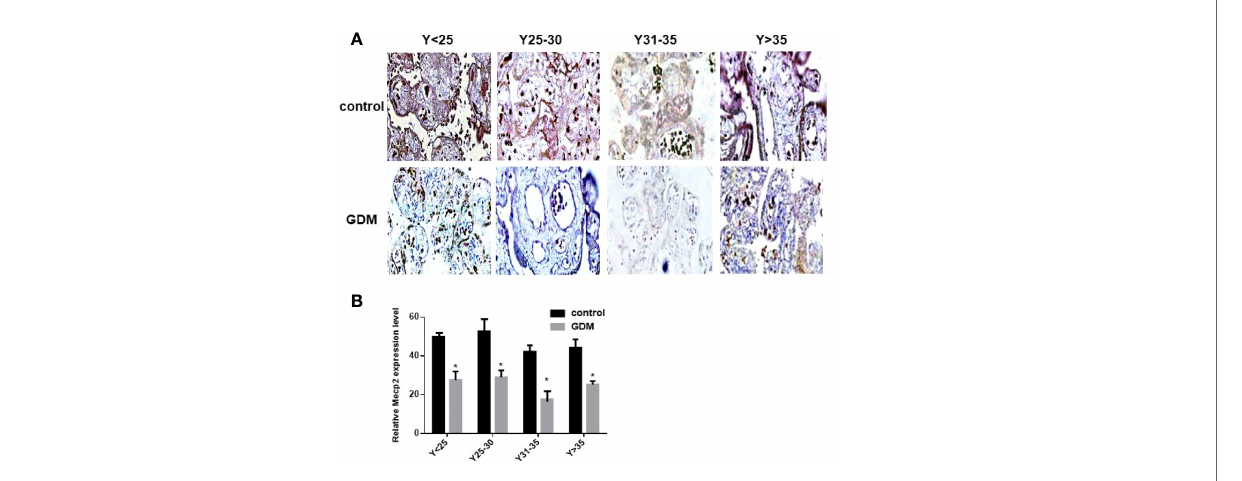
FIGURE 4 | The expression of MeCP2 is down-regulated in the placenta of GDM patients. (A, B) Immunohistochemical assay to detect the expression of MeCP2 in the placenta of GDM patients. Brown is a positive signal. * P